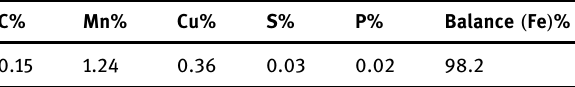
Table 1: Chemical analysis of the test plate